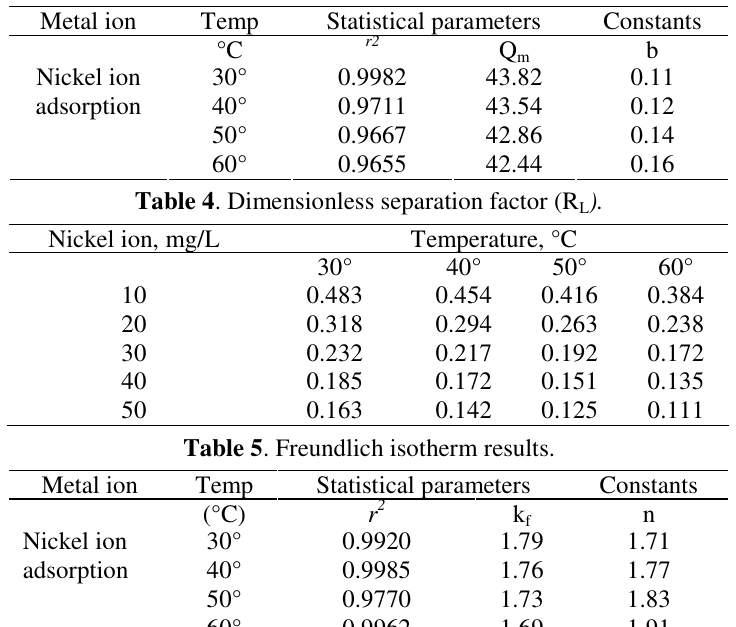
Table 3 . Langmuir isotherm results.